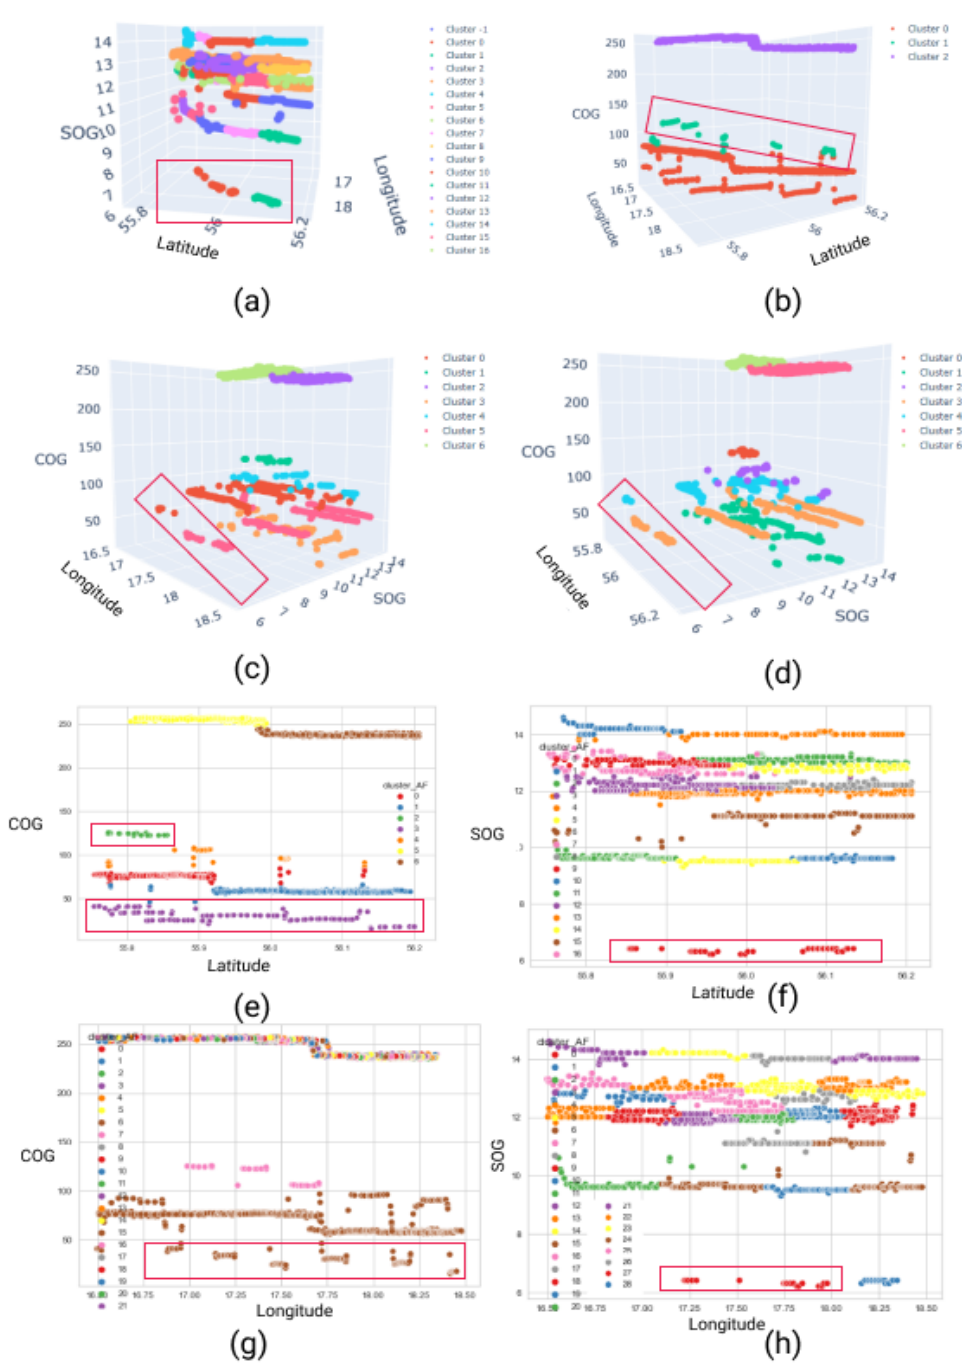
Figure 23. AF clustering results based on the two and three-dimensional inputs ( a – h